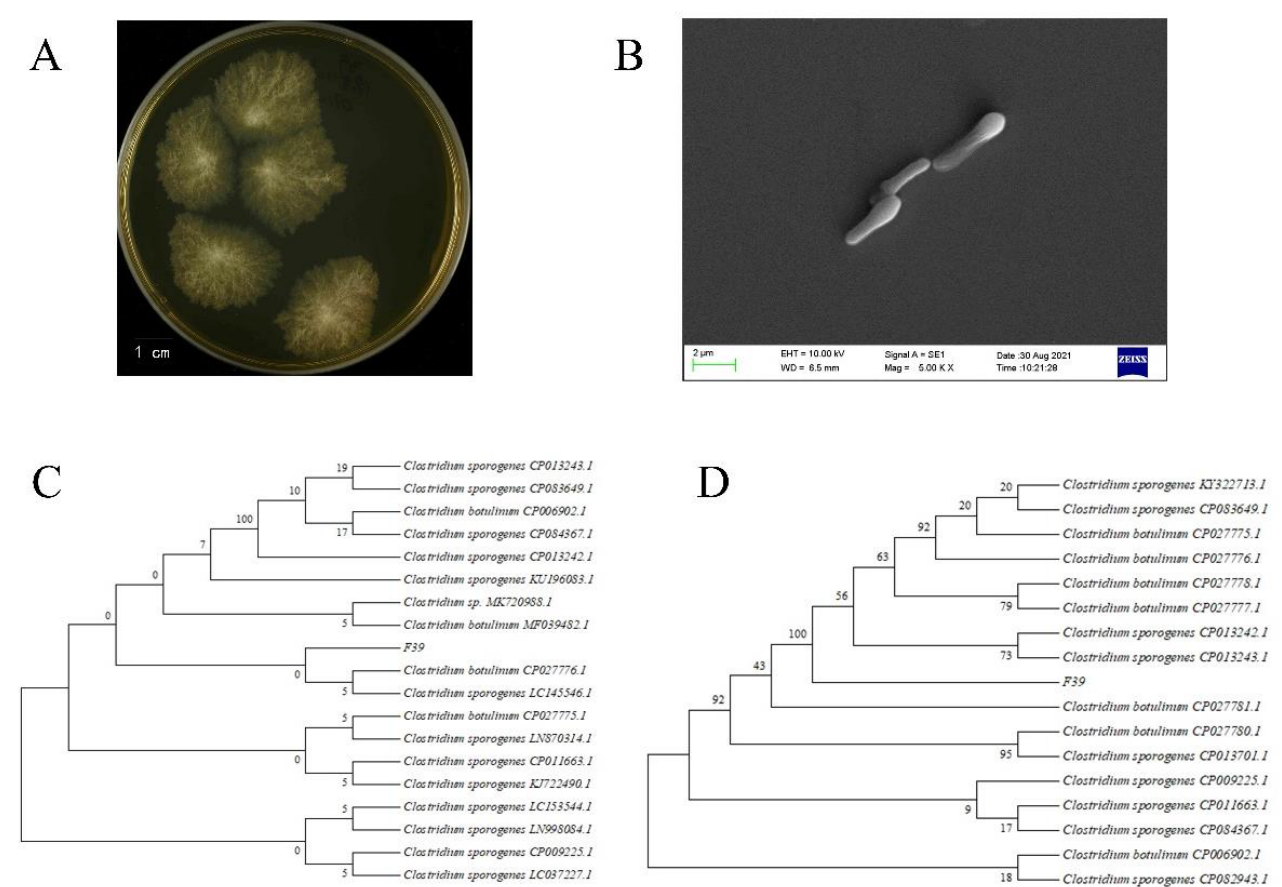
Figure 1. Characterization of F39. ( A ) Colony morphology of F39 on GAM. ( B ) Scanning electron micrograph of F39. ( C ) Phylogenetic tree of F39 based on 16S rRNA gene sequences. ( D ) Phyloge- netic tree of F39 based on rpoB gene sequences.